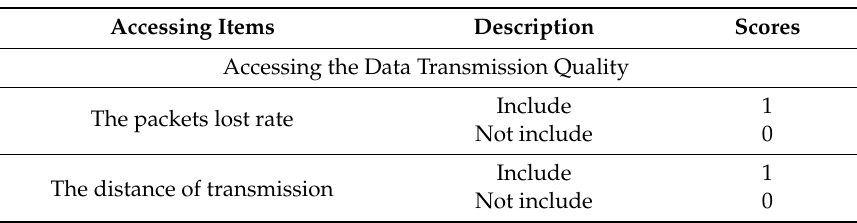
Table 1. Checklist for evaluating studies’